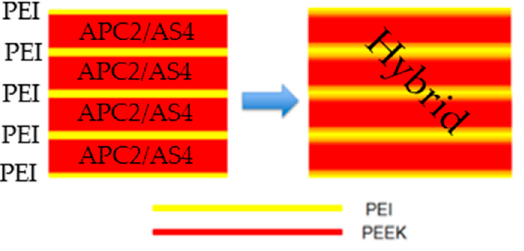
Figure 2. Amorphous bonding concept developed in [9].